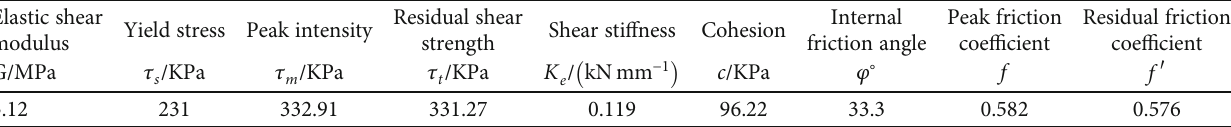
Table 1: Shear strength parameters of slurry rock